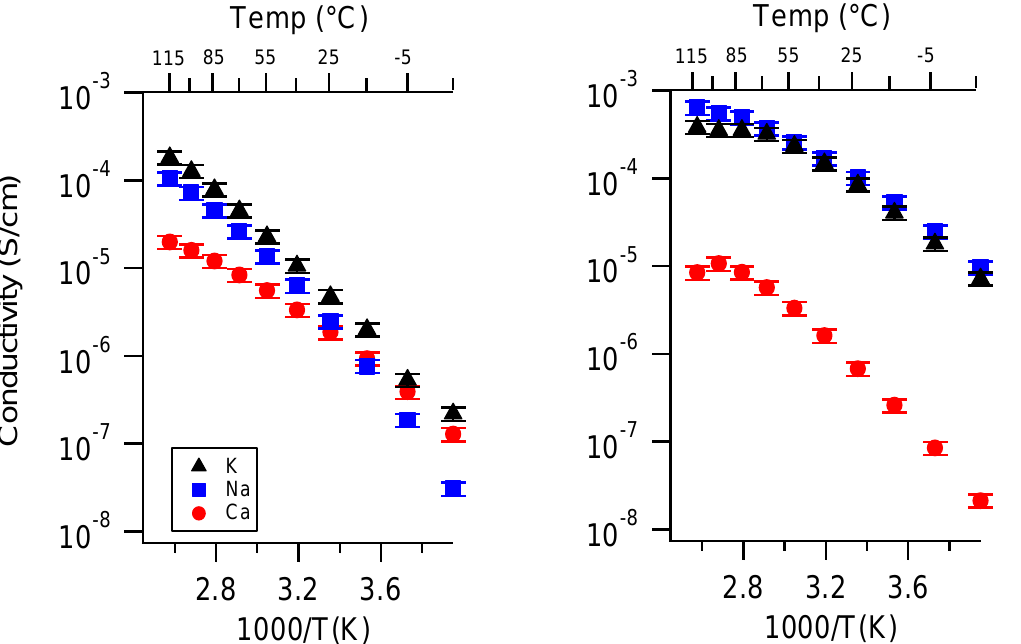
Figure A7. Conductivity as a function of cation for PEGDMA1000_low_SSM (left) and PTHFDA1000_low_STFSI (right) SIPEs swelled with ECPC. Temperatures ranged from − 20 °C to 115 °C.